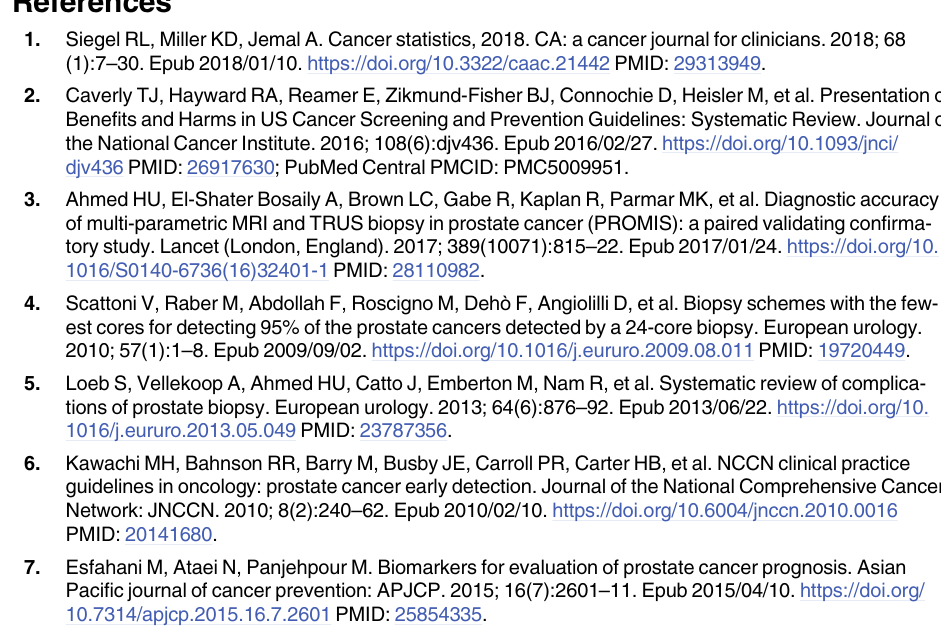
S4 Table. Surface antigen expression on prostate cells from ex vivo clinical specimens and in vitro model cell lines of malignant and non-malignant